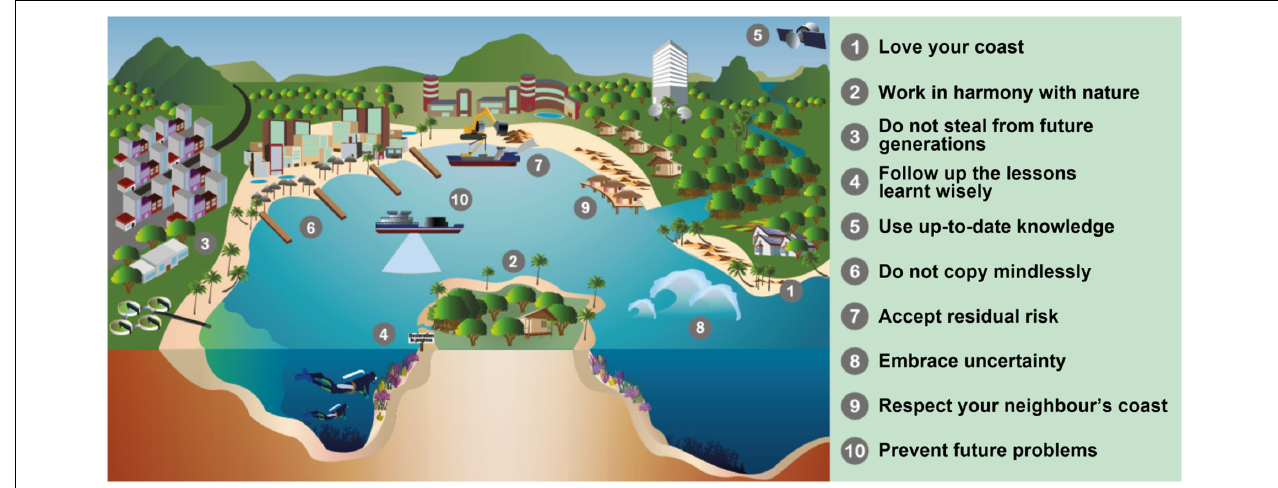
FIGURE 1 | Ten commandments for sustainable, safe, and W/Healthier sandy coasts facing global change.